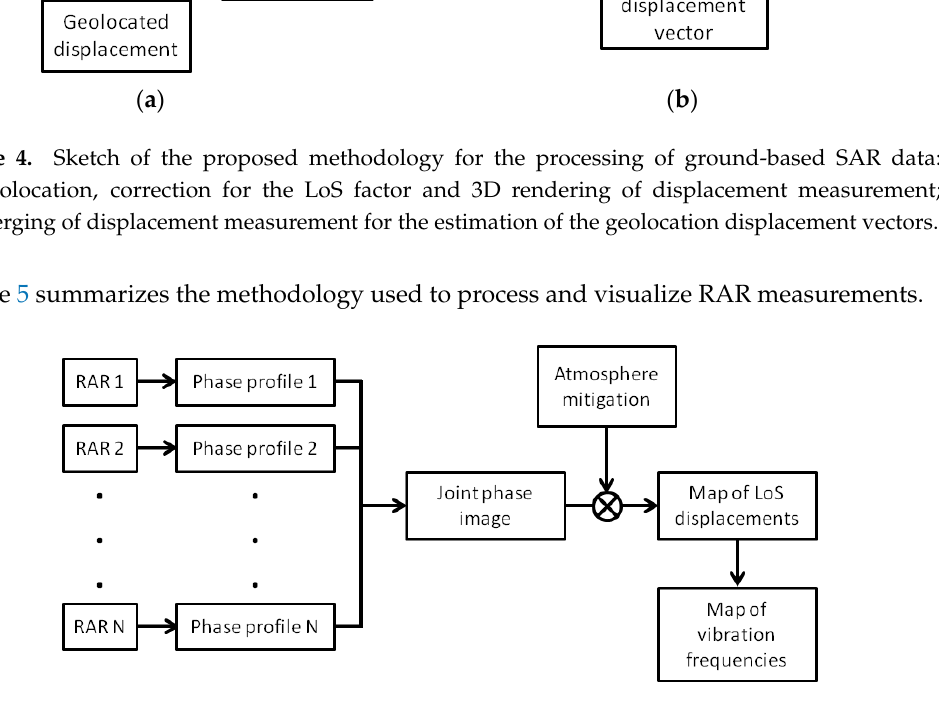
Figure 5. Sketch of the proposed methodology for the processing of ground-based RAR data.